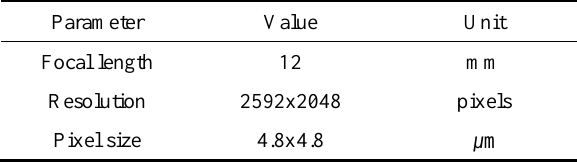
Table 1. The image sensor specification